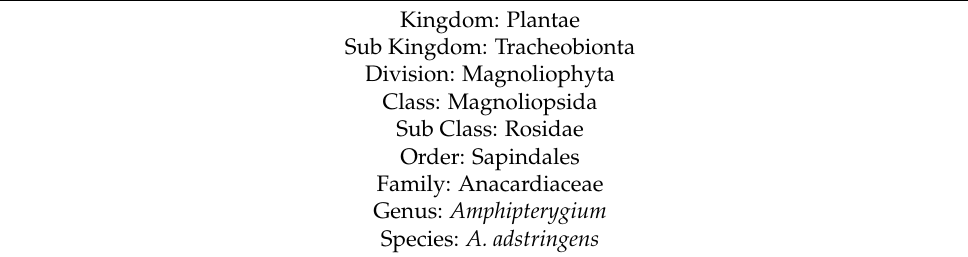
Table 1. Botanical classification of A. adstringens